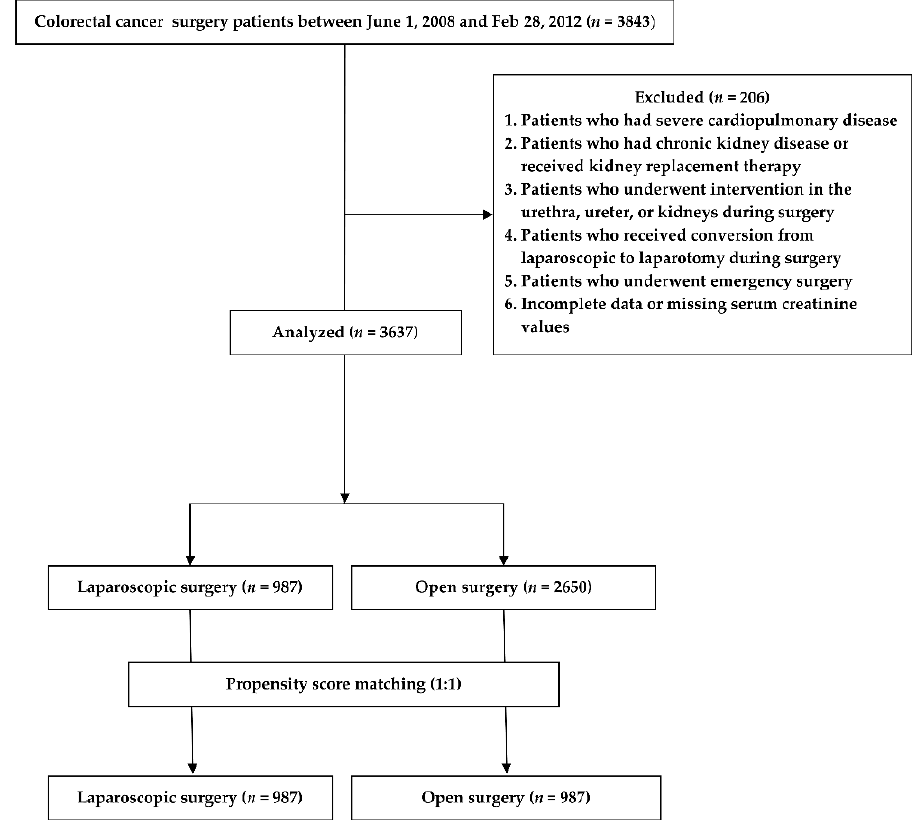
Figure 1. Study flow chart.